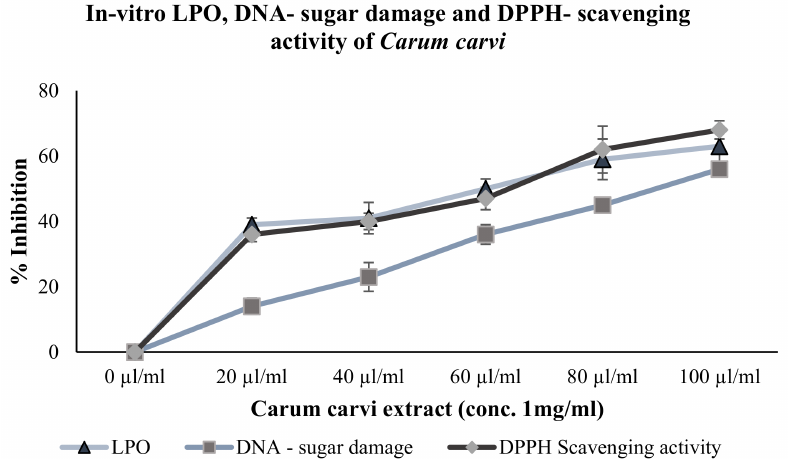
Figure 2. In vitro DPPH-scavenging activity, LPO inhibition, and DNA-sugar damage by Carum carvi extract. Representative graphs showing concentration-dependent activity of Carum carvi in terms of DPPH scavenging, LPO inhibition, and DNA-sugar damage. All samples were analyzed in